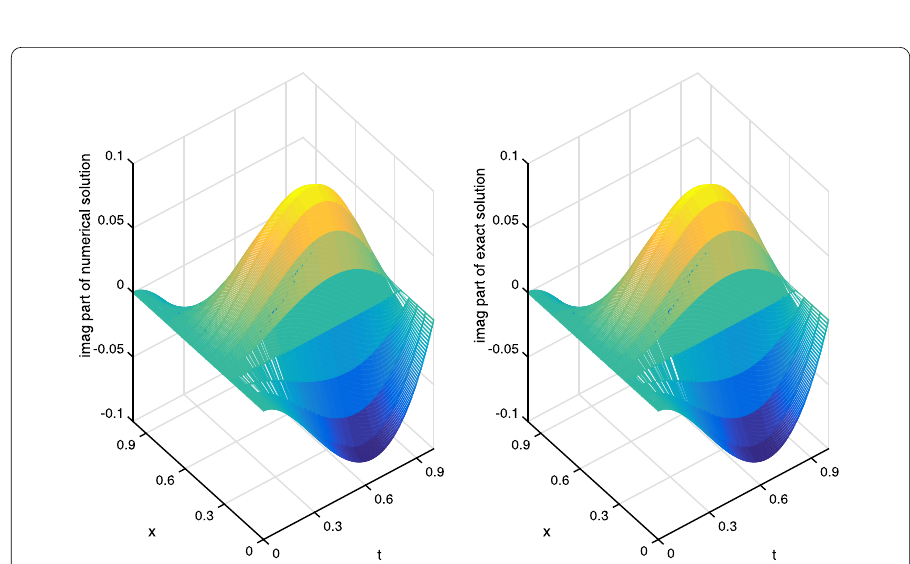
Figure 6 (Example 6.3) Imaginary part of numerical solution and exact